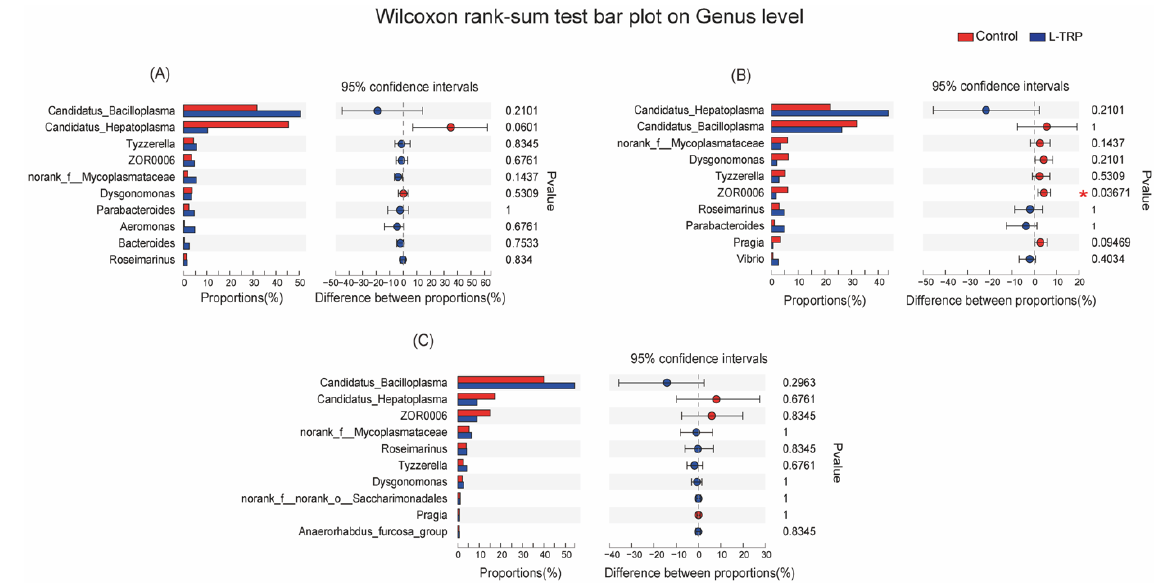
Figure 8. Differences in bacterial abundance in the intestinal microbial community of E. sinensis (genus level) in August ( A ), September ( B ) and November ( C ). Different colored bars indicate different groups, and the rightmost value was the p -value and showed the bacterial abundance differences between the control and L-TRP groups, * 0.01 < p ≤ 0.05.